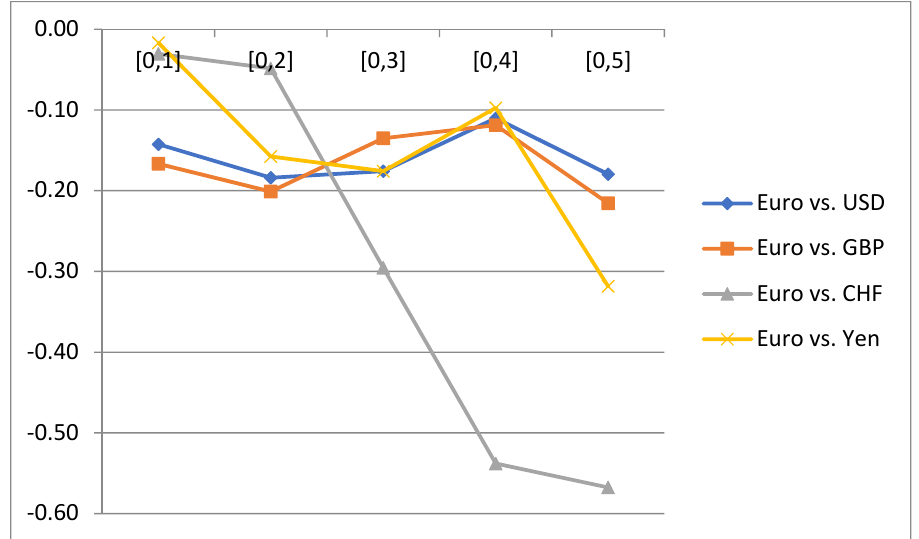
Figure 3. Summary of Results-Mean CAR (%). Notes: the above chart depicts mean CAR for all event days and for all currency pairs, across all five event windows.